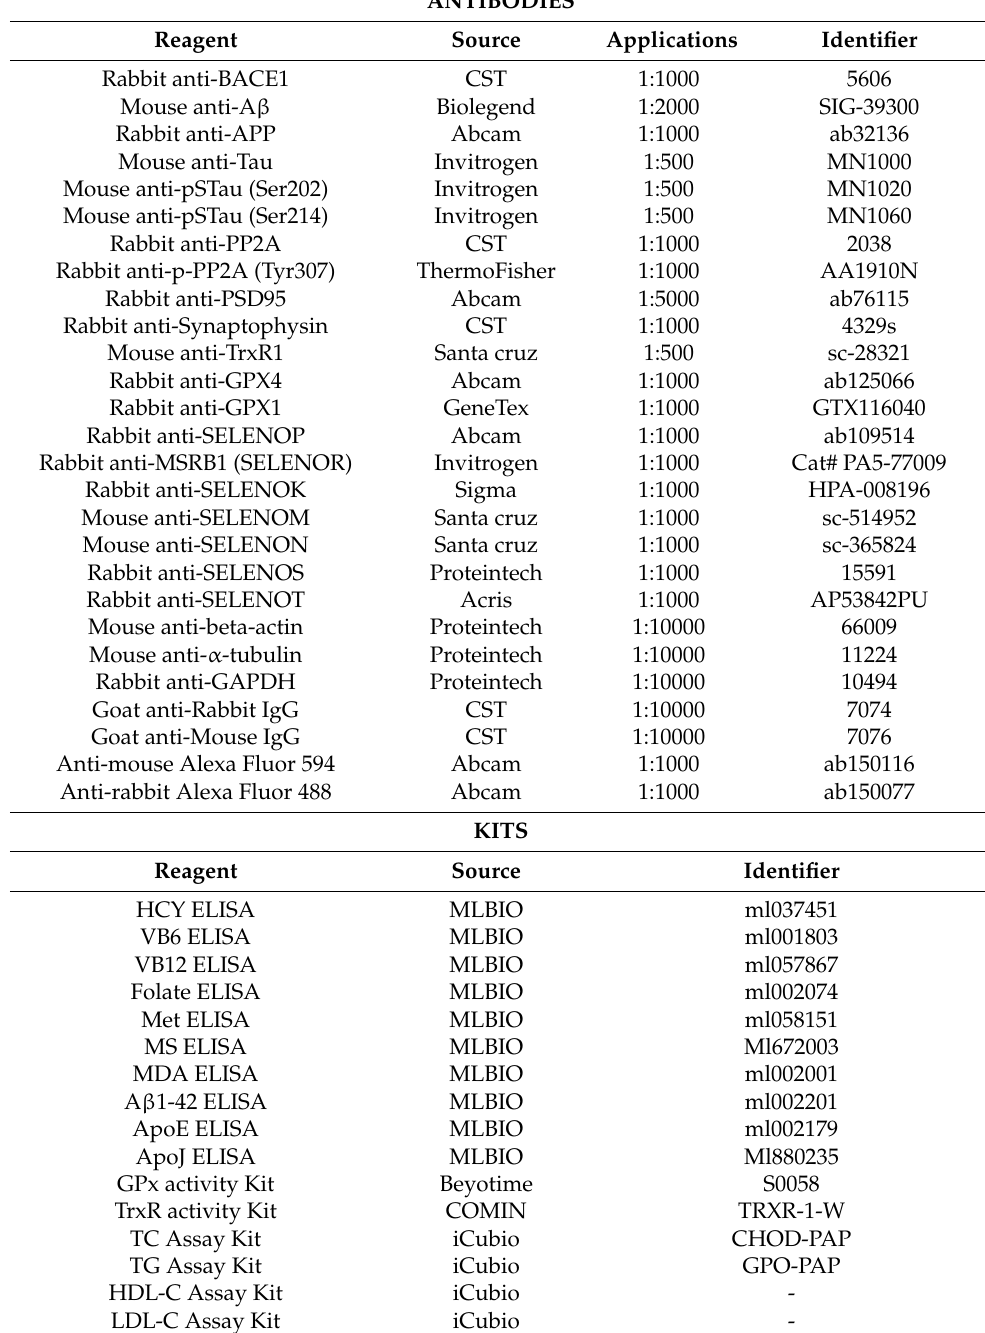
Table 3. Antibodies and